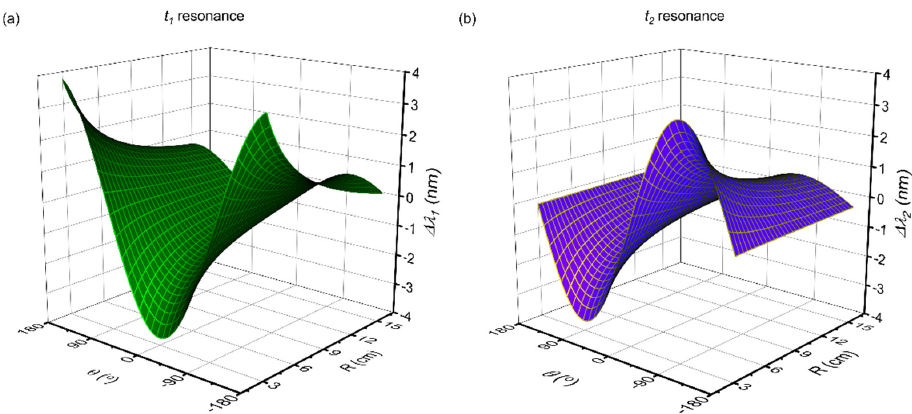
∆ λ ( R , θ ) and ( b ) ∆ λ 1